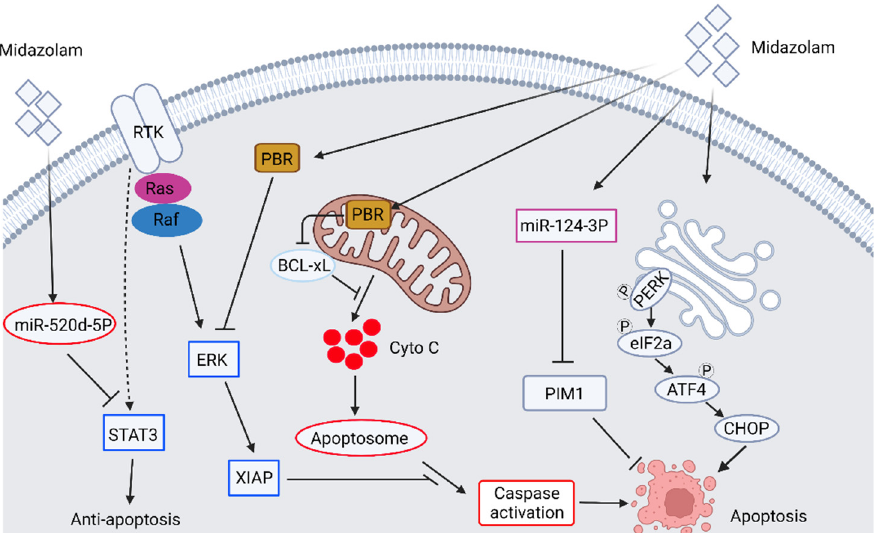
Figure 1. Schematic illustration of midazolam-induced apoptotic signaling in cancer cells. The figure is made by an online tool at BioRender.com (accessed on 14 June 2022).